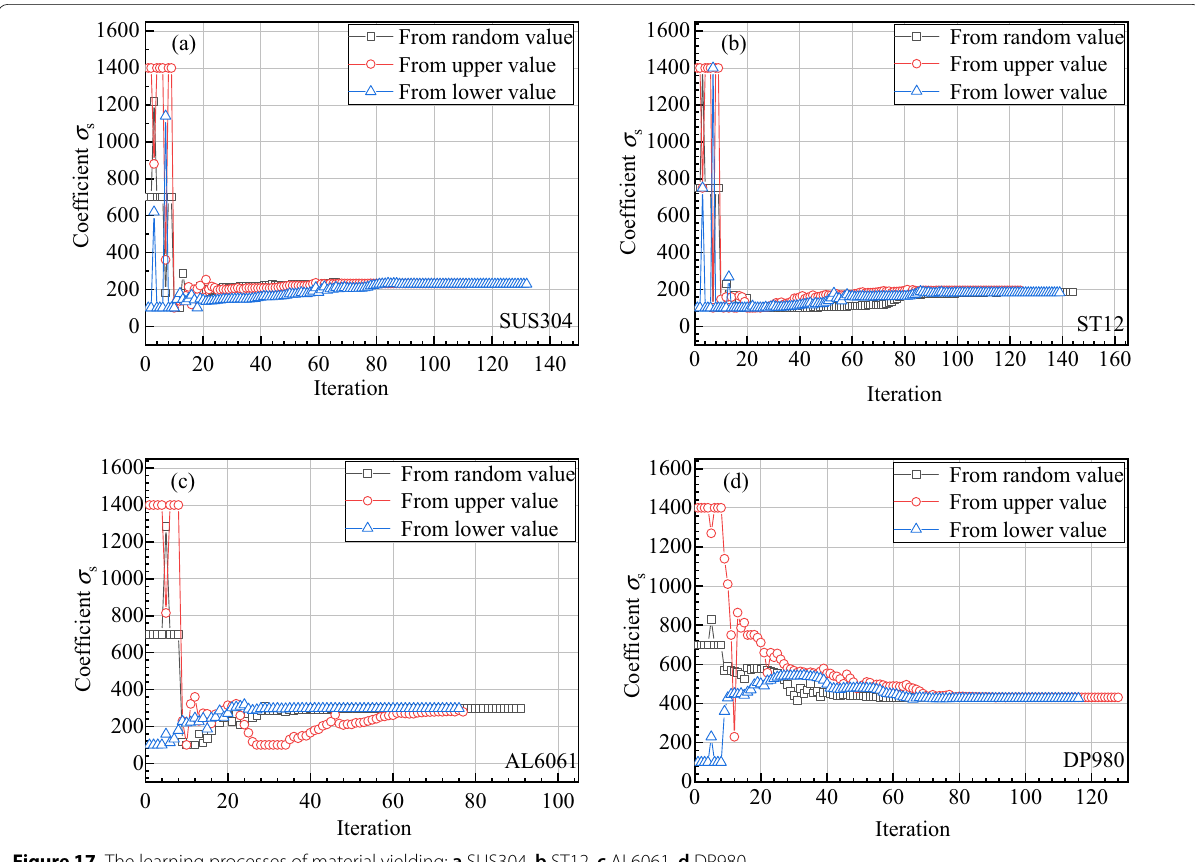
Figure 17 The learning processes of material yielding: a SUS304, b ST12, c AL6061, d